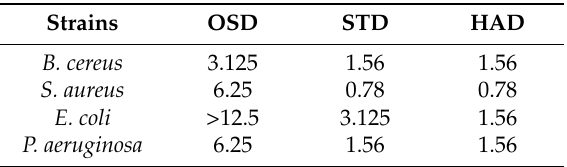
Table 4. Minimum inhibition concentration (MIC) of ginger, dried with different methods, against bacteria strains.